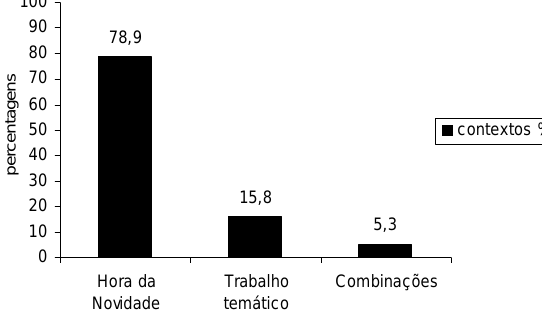
Figura 2 . Percentagem de narrativas eliciadas (NEs) nos dife- rentes contextos